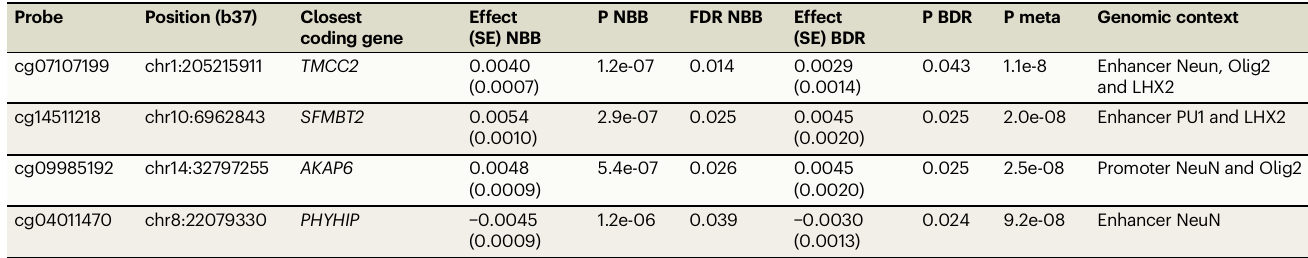
Table 1 | Replicating CpG probes associated with Braak Lewy body stage Probe